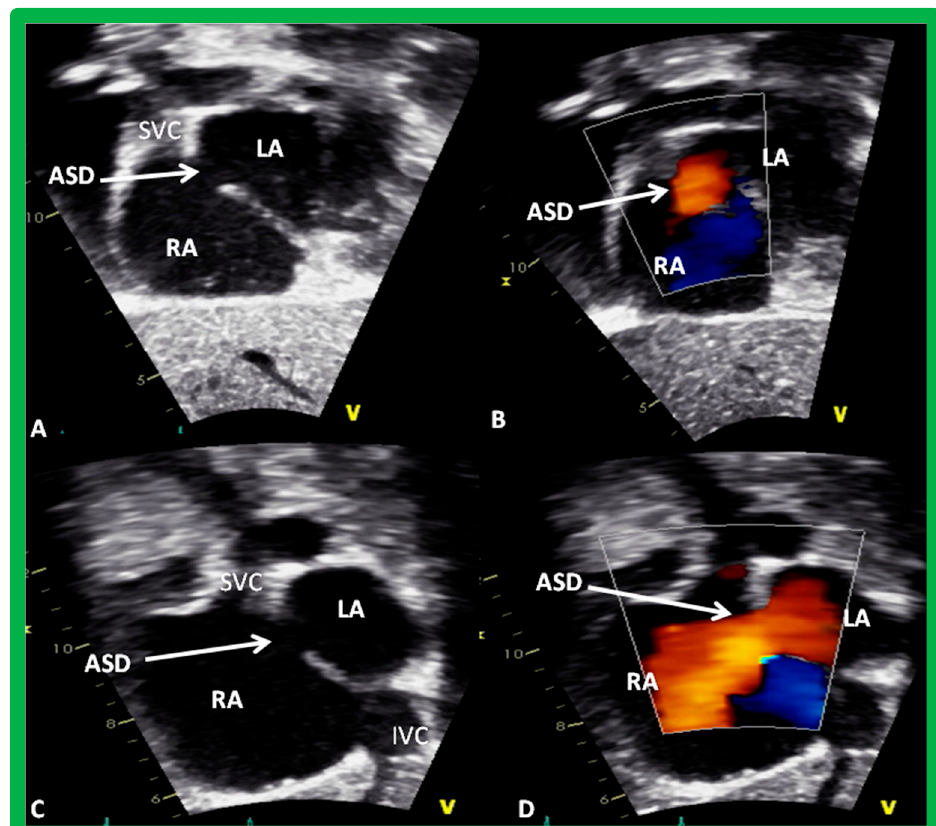
Figure 7. Two-dimensional subcostal long ( A , B ) and short ( C , D ) -axis projections from a transthoracic echo study illustrating an atrial septal defect (ASD) ( A , C ). Color flow imaging ( B , D ) demonstrates left-to-right shunt. IVC, Inferior vena cava; LA, left atrium; RA, right atrium; SVC, superior vena cava. Reproduced from Reference [7].